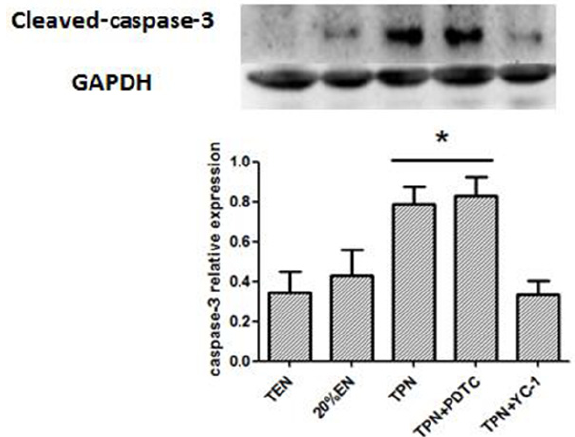
Figure 10. Western blotting analysis of cleaved caspase ‐ 3 in the intestine mucosa. Compared with TEN group, TPN and TPN + PDTC had increased cleaved caspase ‐ 3 expressions ( p = 0.037 and 0.045). There is no difference among other groups. * p < 0.05, compared with TEN group.